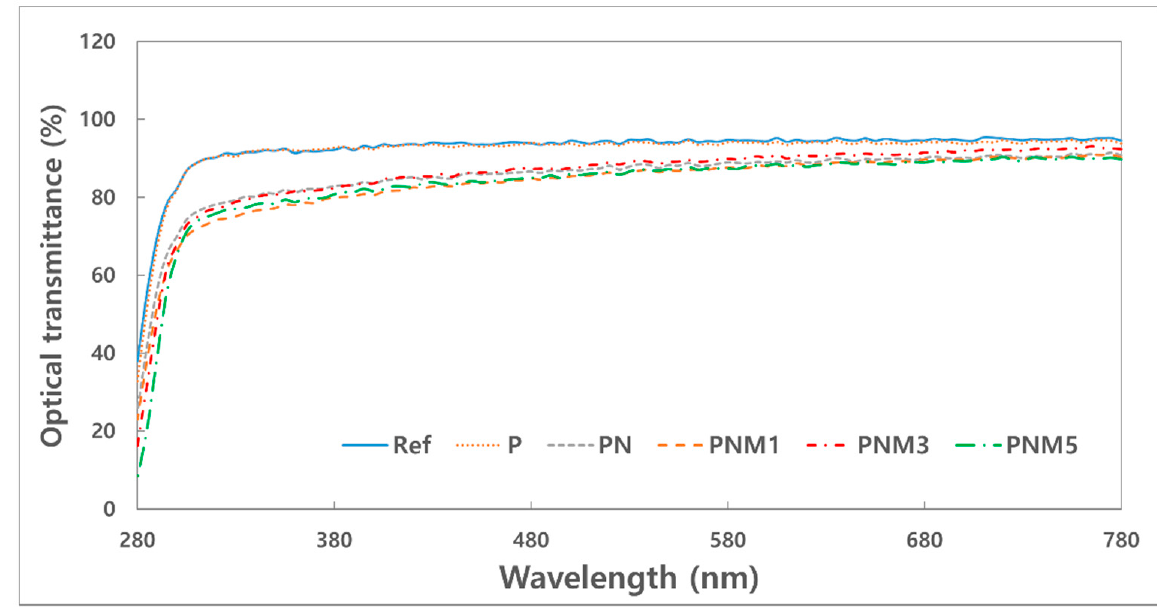
Figure 2. Optical transmittance of samples.